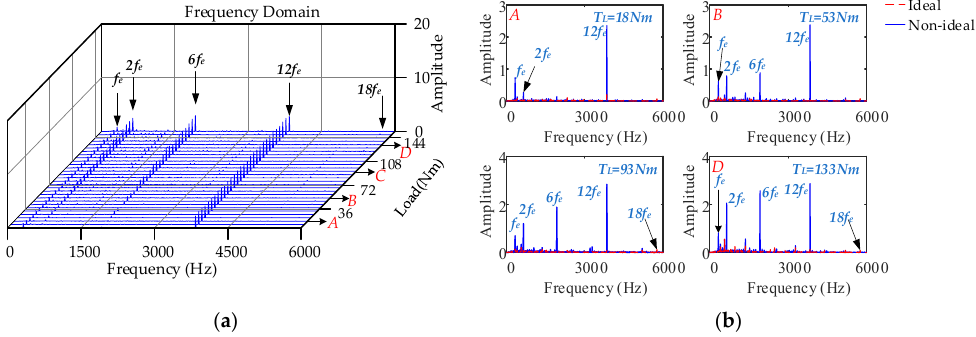
Figure 28. Frequency domain results of electromagnetic torque under different loads: ( a ) waterfall diagram of electromagnetic torque; ( b ) comparison results of electromagnetic torque. diagram of electromagnetic torque; ( b ) comparison results of electromagnetic